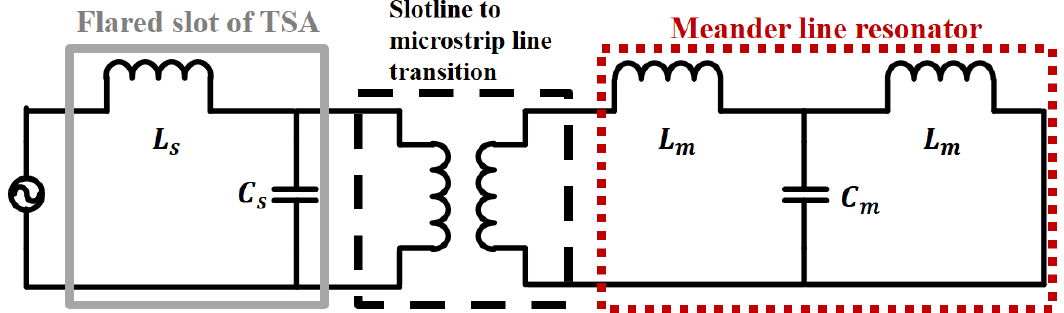
Figure 8. The equivalent circuit model of the meander line resonator with TSA.